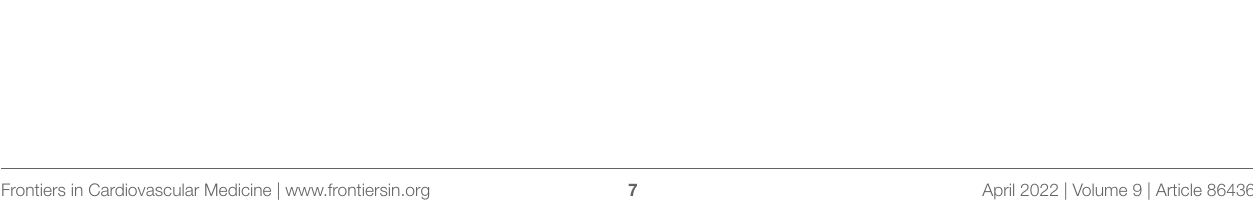
Frontiers in Cardiovascular Medicine |